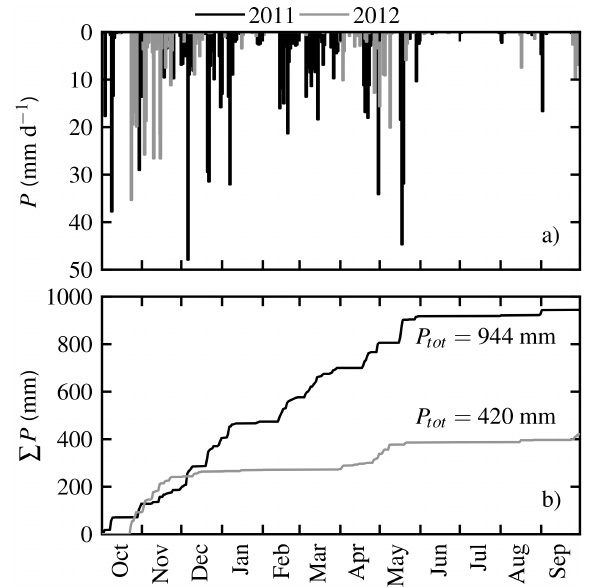
Figure 2. (a) Daily sum of precipitation P for 2011 (black) and 2012 (grey). (b) Cumulative precipitation P for 2011 (black) and 2012 (grey) based on half-hourly